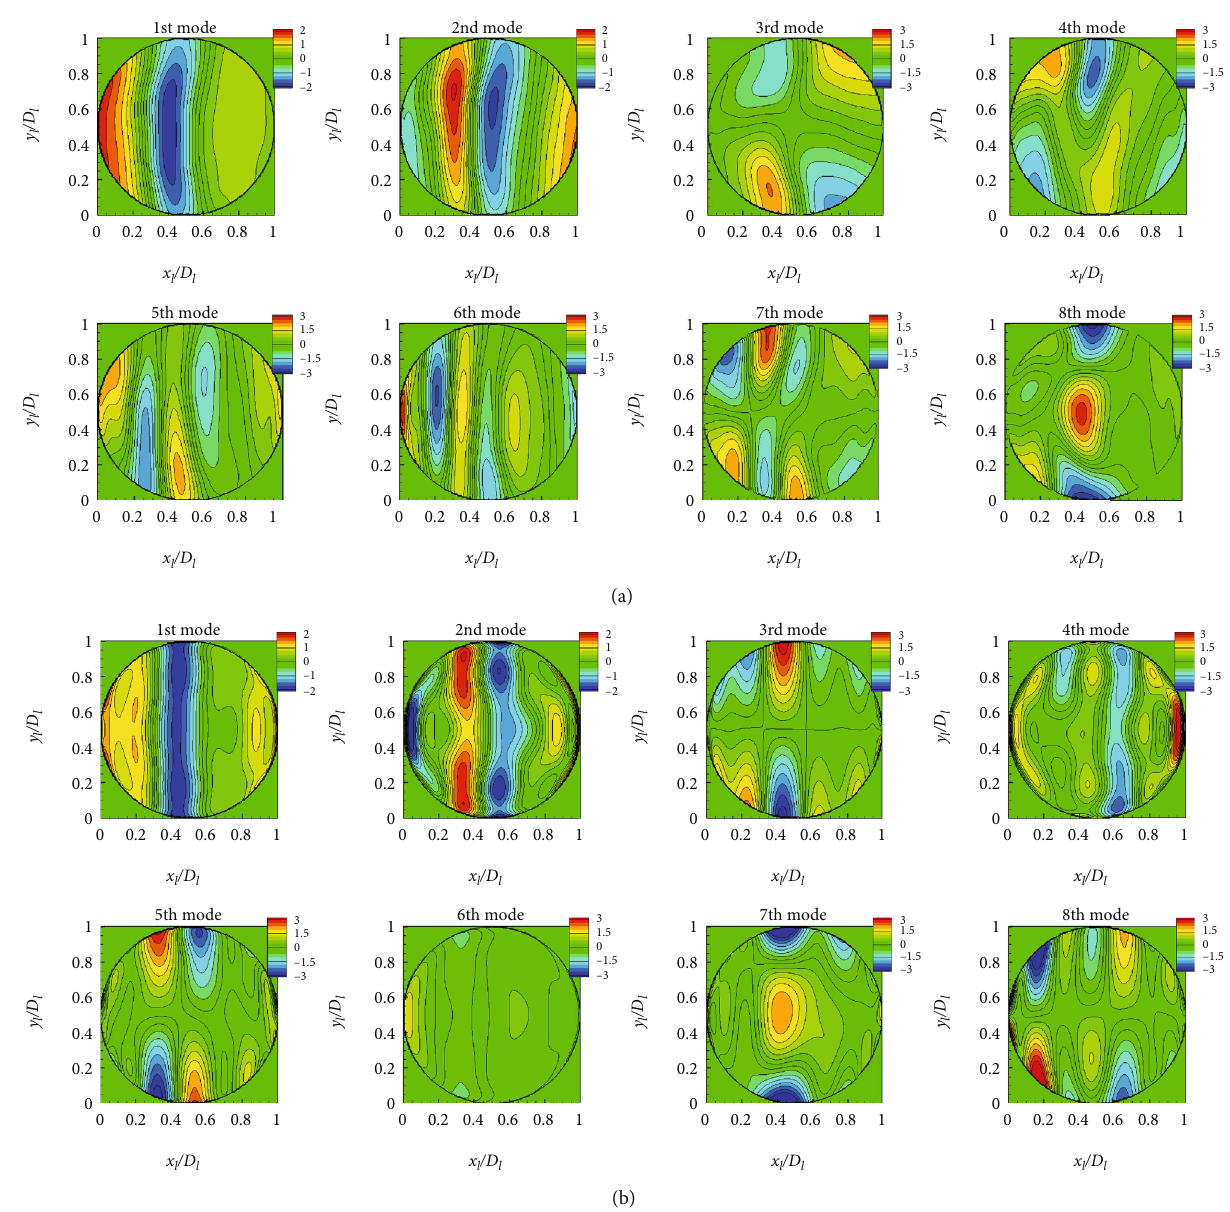
x y λ : (a) experiment and (b) k ð l , l Þ /